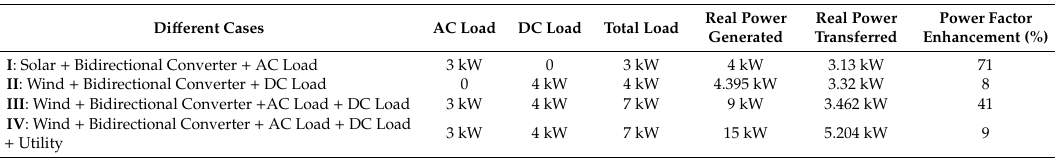
Figure 20. Reactive power from the bidirectional converter. Table 3. Results for the case